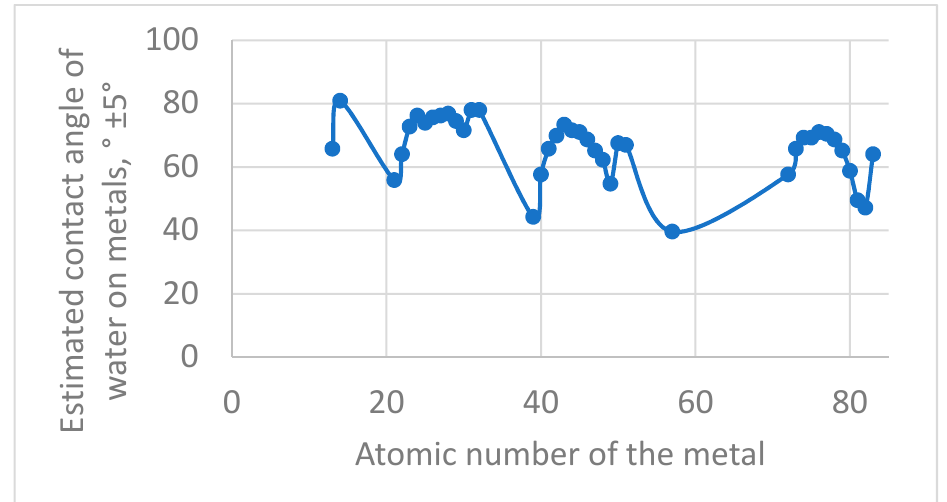
Figure 6. Contact angle values determined by Equation (1) as a function of the atomic number. Table 2. Comparison of the estimated and measured contact angle of water on Al, Si and Mo sur- faces.